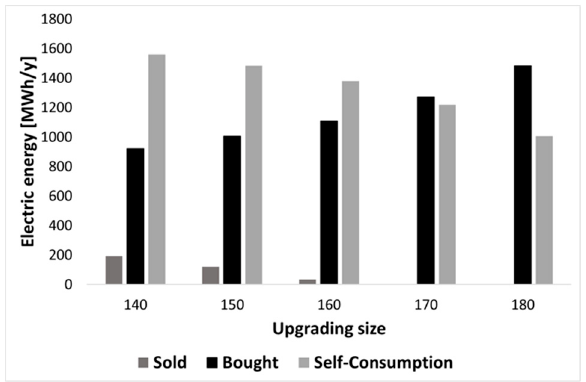
Figure 18. Sold, bought and self-consumed energy as a function of the upgrading size.